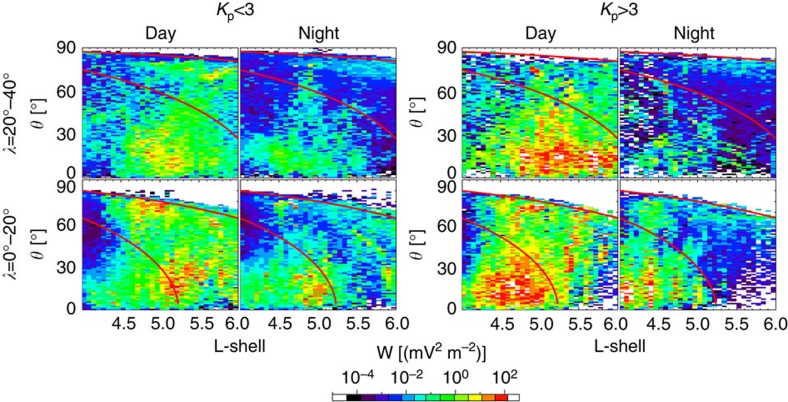
Distribution of the energy of whistler waves in the Earth radiation belts.The distribution of the density of whistler wave energy W (in mV2 m−2) is displayed in the (L,θ) space. Data are shown for two ranges of magnetic latitude (the near-equator region with |λ|∈[0°,20°] and the high-latitude region with |λ|∈[20°,40°]), for day and night sectors, and for low (Kp<3) and high (Kp>3) geomagnetic activity. Red curves show the position of Gendrin θg and resonance cone θr angles (where cosθg≈2ω/Ωc, cosθr≈ω/Ωc and Ωc is the local electron gyrofrequency). Both angles are calculated with the mean frequency of spacecraft observations, making use of precise plasma density measurements from IMAGE39. In the present figure, the wave refractive index has been limited to <100 in agreement with rough but conservative upper bounds due to Landau damping by average levels of hot electrons19. Three frequency channels have been taken into account: 2,244.9, 2,828.4 and 3,563.6 Hz, covering almost the full range from 2 to 4 kHz. Each channel is used in the corresponding L-shell range to measure only waves in whistler-mode frequency range.